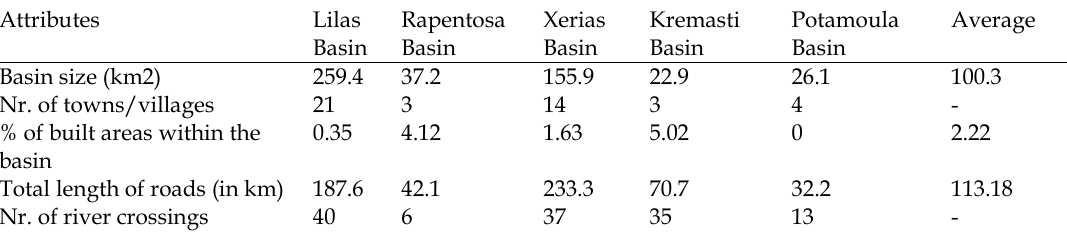
Table 1. Basic attributes of the examined basins Attributes Lilas Basin size